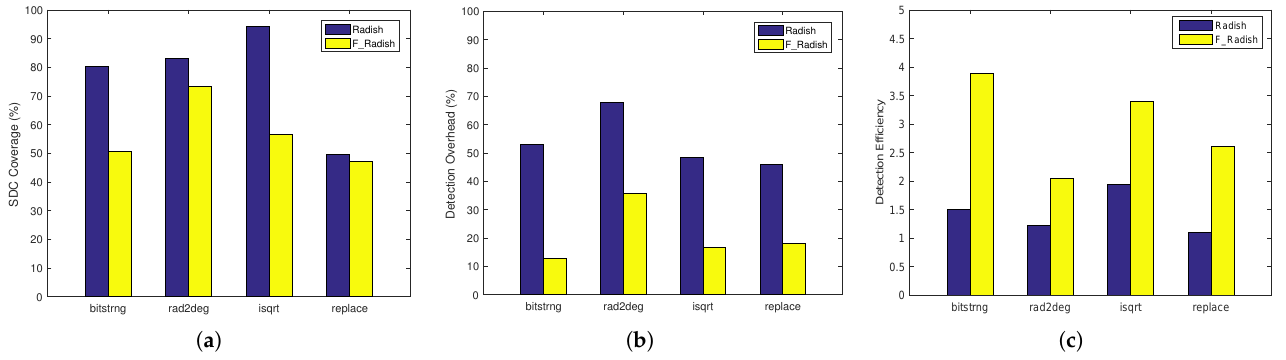
Figure 6. The performance of F_Radish and Radish on ( a ) silent data corruption (SDC) coverage, ( b ) detection overhead, ( c ) detection